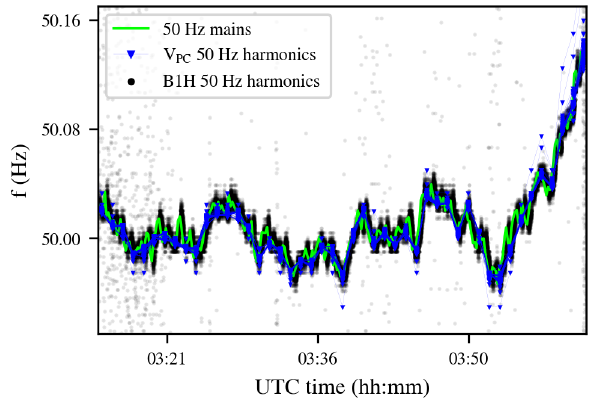
FIG. 6. The mains power supply ripple frequency (green), the frequency evolution of the harmonics observed in the voltage spectrum of the main dipoles power supply of sector 1-2 (blue) and the ones of the beam spectrum (black), after normalizing with the order of each harmonic h